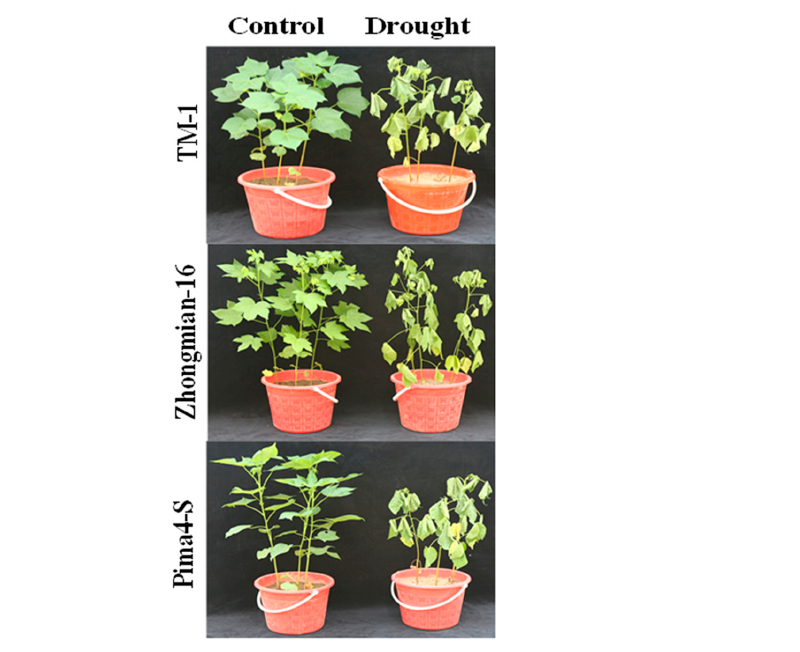
Figure 1. Phenotype of TM-1, Zhongmian-16, and Pima4-S species affected by drought stress.